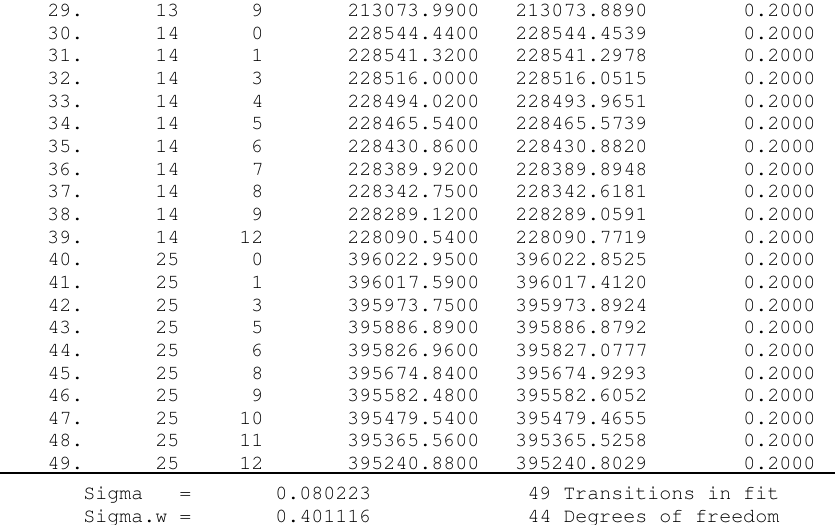
Table 15 . Comparison of rotational parameters of 13 CD previous work 22 in the ground state. 13 CD 3 CN CD parameters Ref.